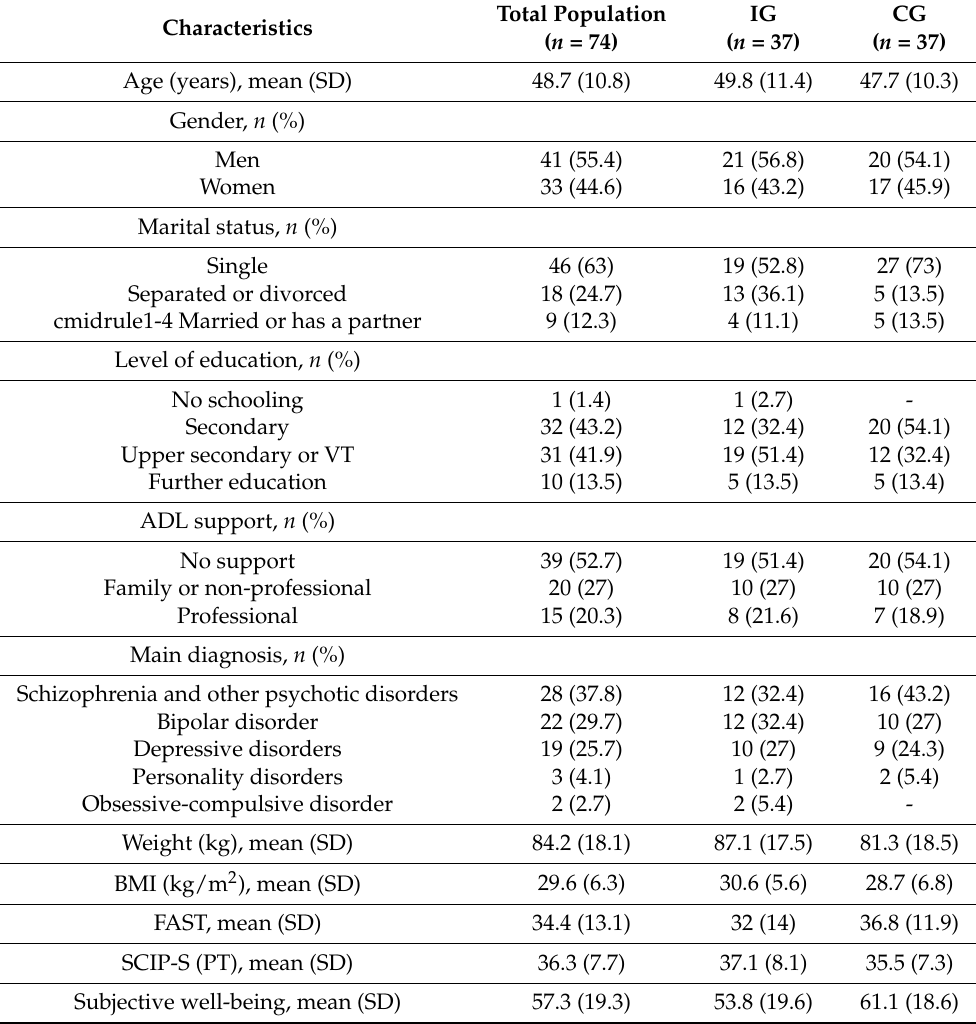
Table 2. Baseline sociodemographic and clinical characteristics of